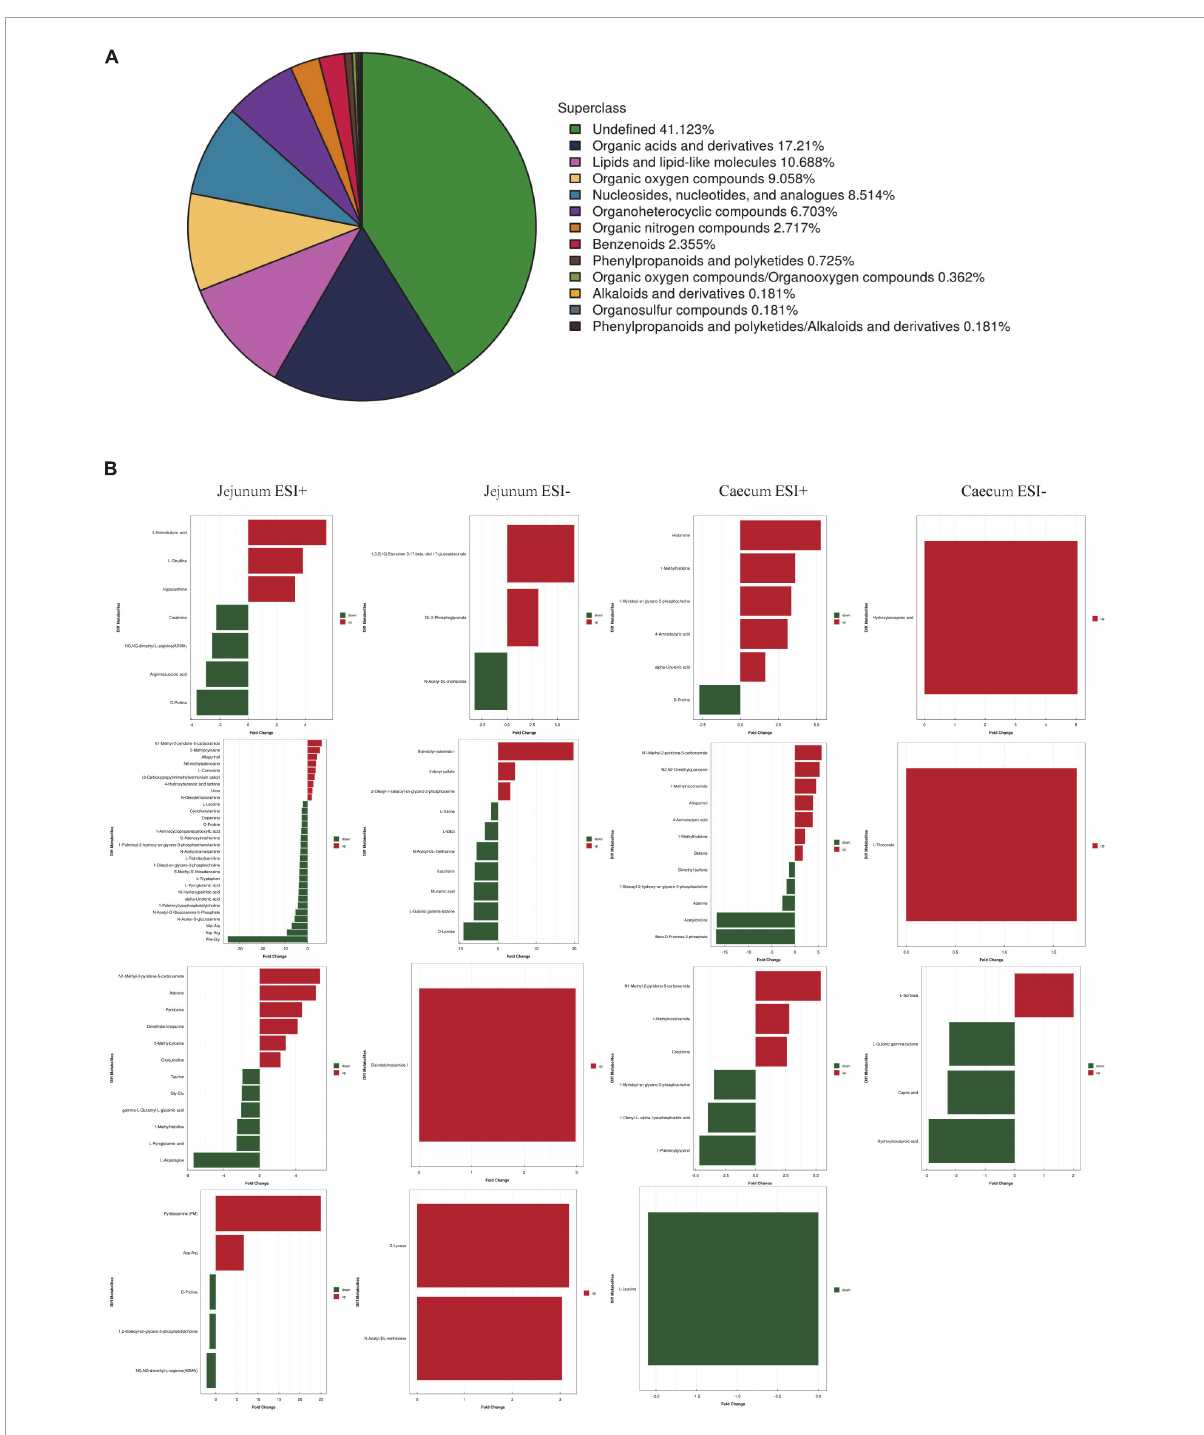
FIGURE4 (A) Chemical classification of metabolite composition. (B) Fold change analysis of different